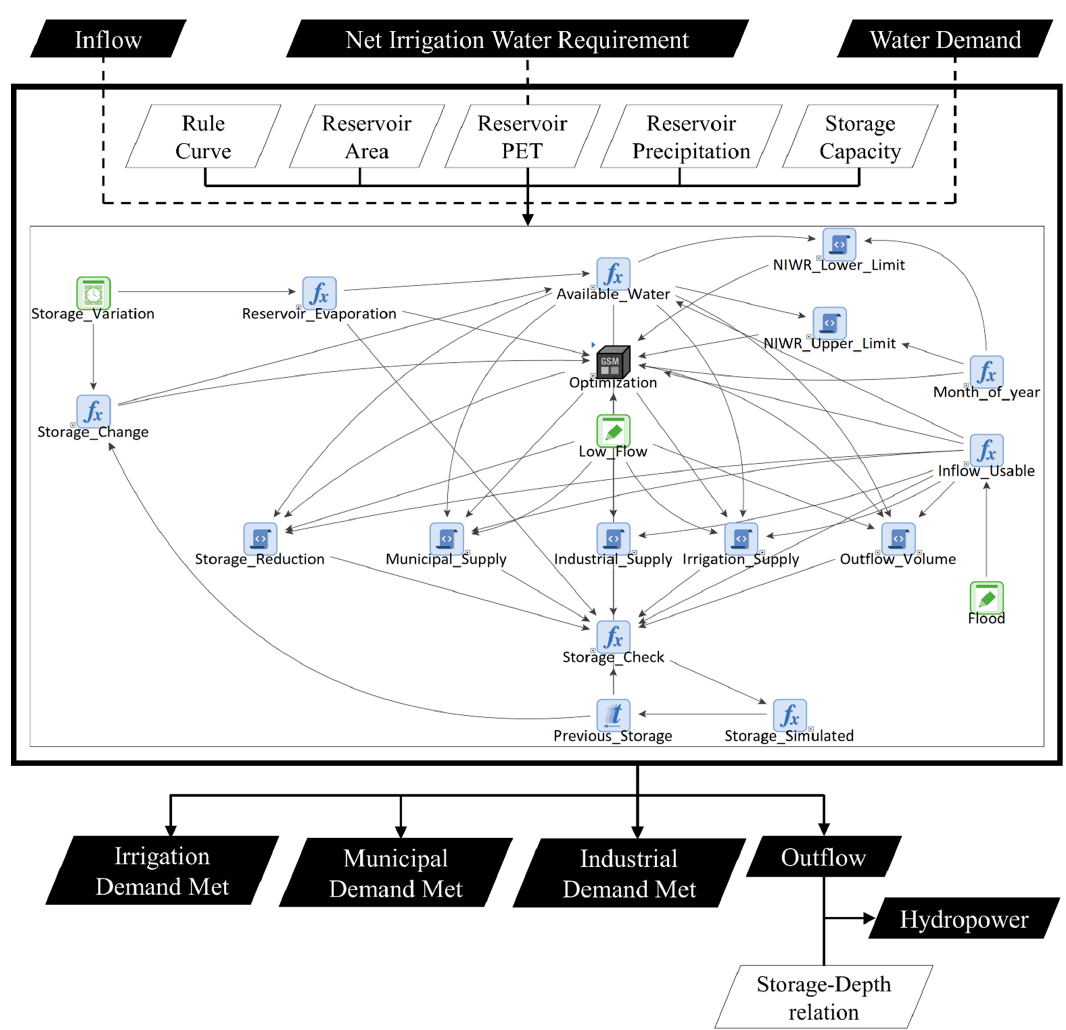
Figure 2. Schematic of coupled food–energy–water systems dynamics modeling using the MekSyD model for the MRB.